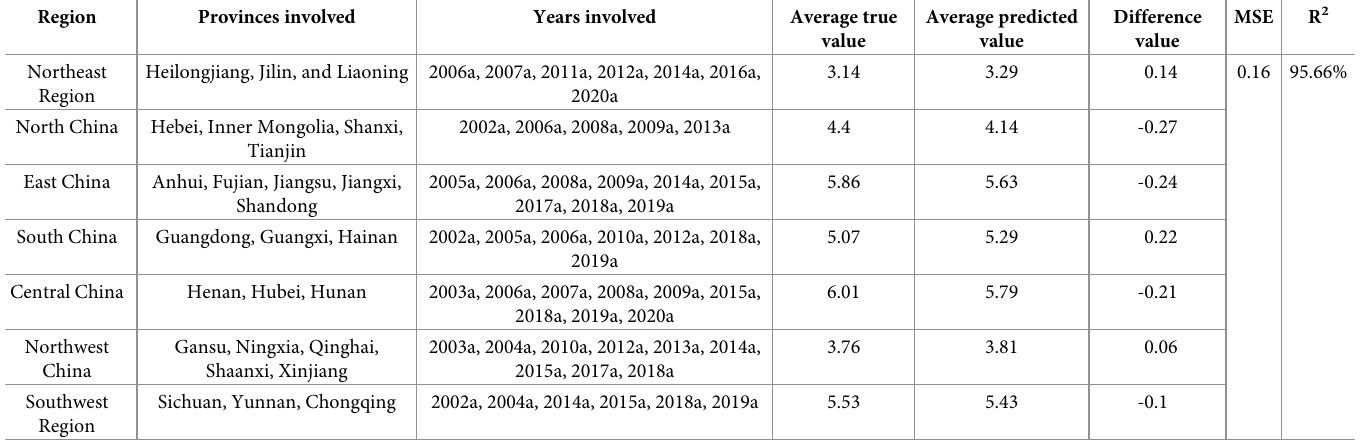
Table 5. XGBOOST model test set verification results description.